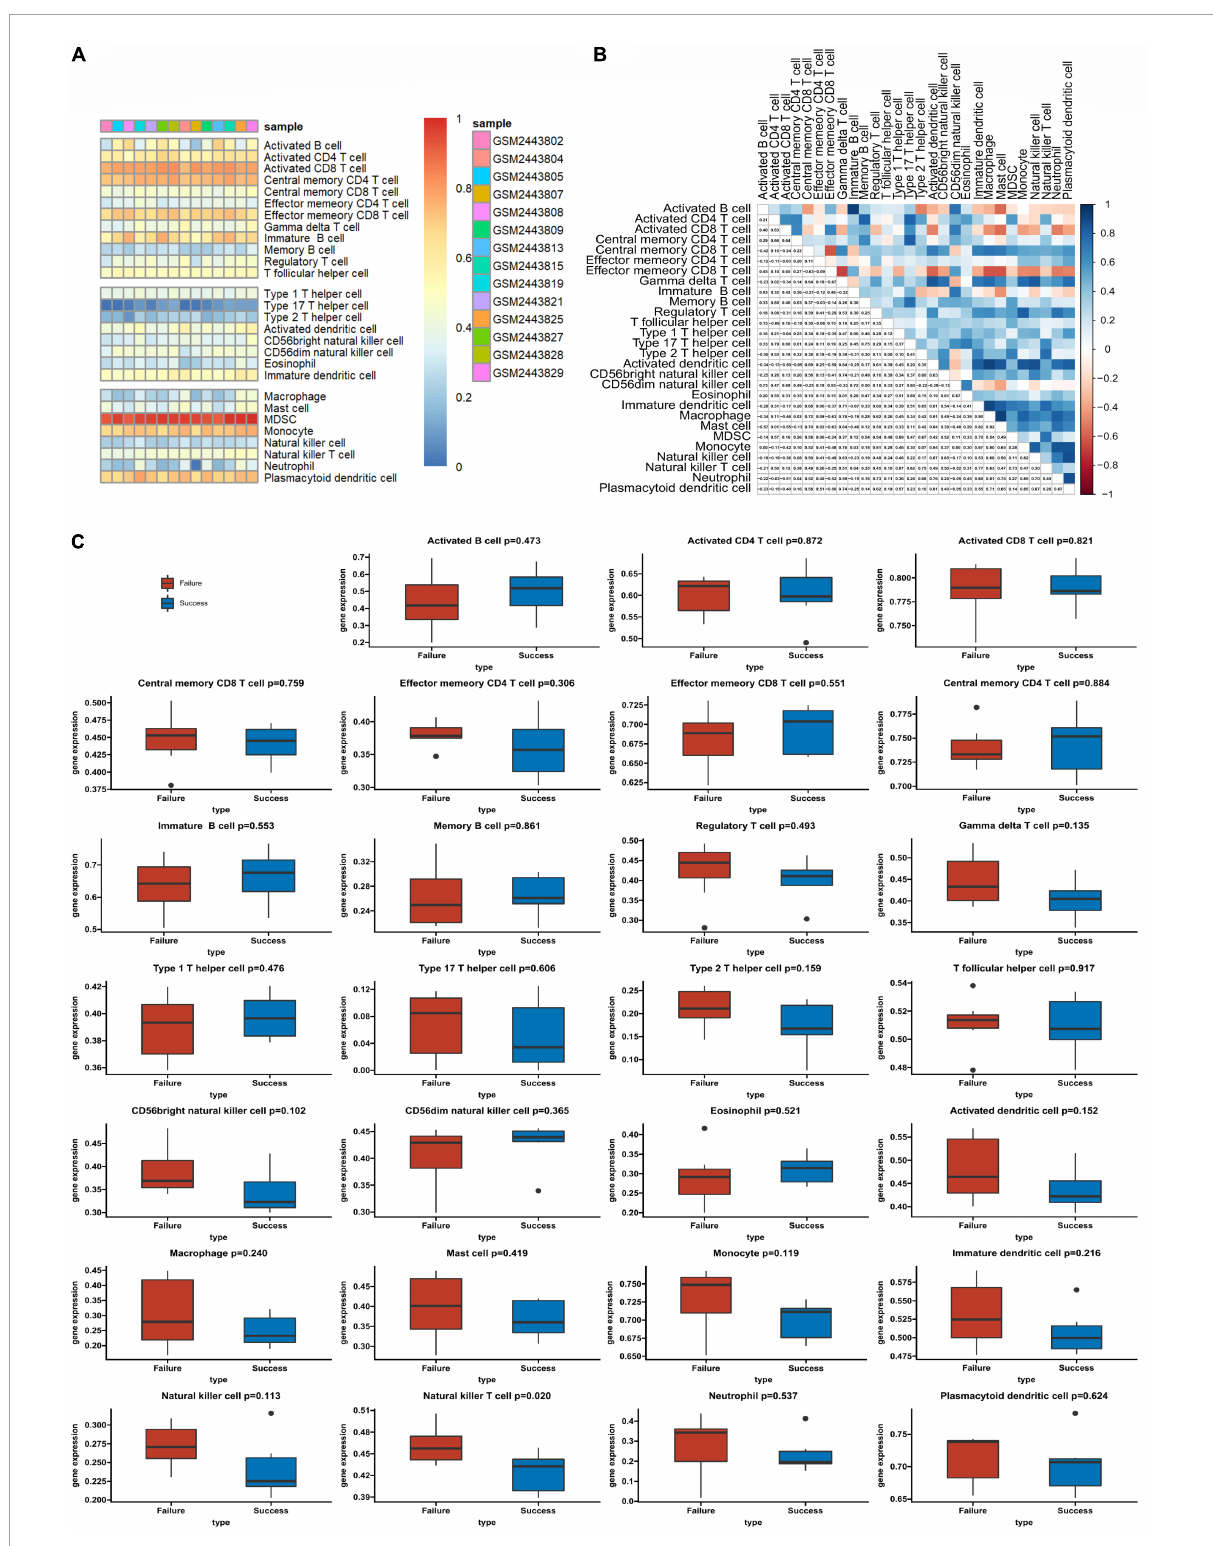
FIGURE5 The profiles of immune cell subtype distribution patterns in the GSE93101 dataset. (A) Bar plot visualizing the relative percentage of 28 immune cells in each sample. (B) Heatmap plot of the correlation between 28 immune cells; blue and red represent positive and negative correlations, respectively. (C) Histogram of all 28 differentially infiltrated immune cell